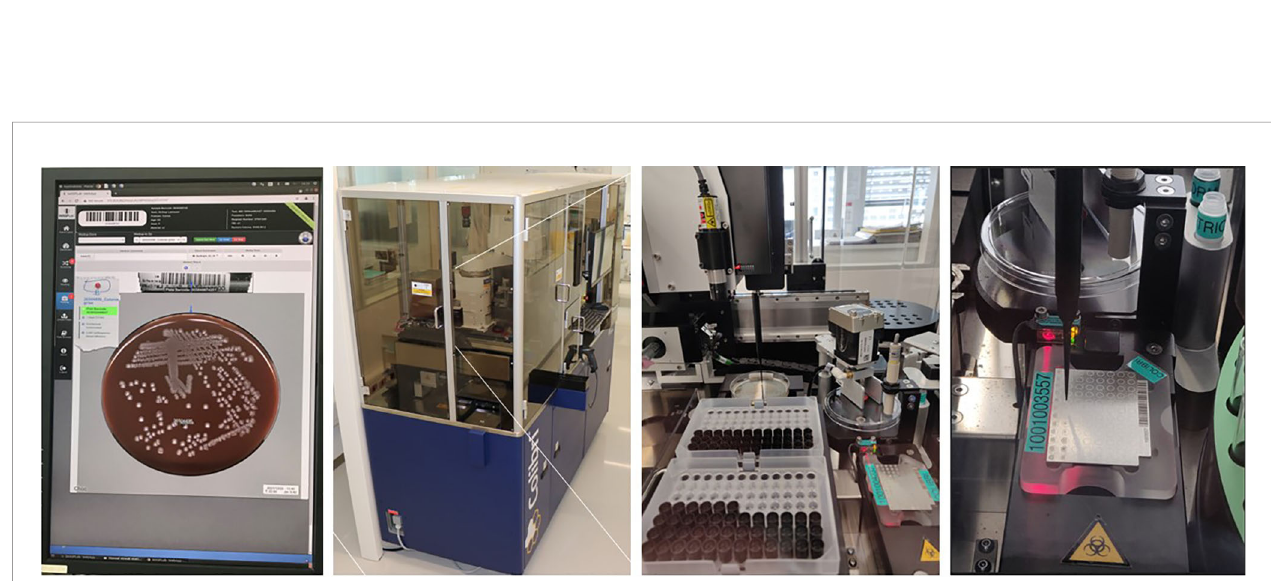
FIGURE 3 | Automated System for Colony Picking and MALDI-TOF Targets Preparation (Copan Colibr ı ™ ́ ). A pipetting system permits: i) the picking of the speci fi c colonies determined by the technologists during the reading step on the WASPLab screen; ii) the transfer of the microorganisms ’ cells on the MALDI-target; and iii) the deposition of the matrix. Two protocols are available with (or without) extraction using a formic acid. Source of all images: A. Cherkaoui, Geneva University Hospitals.